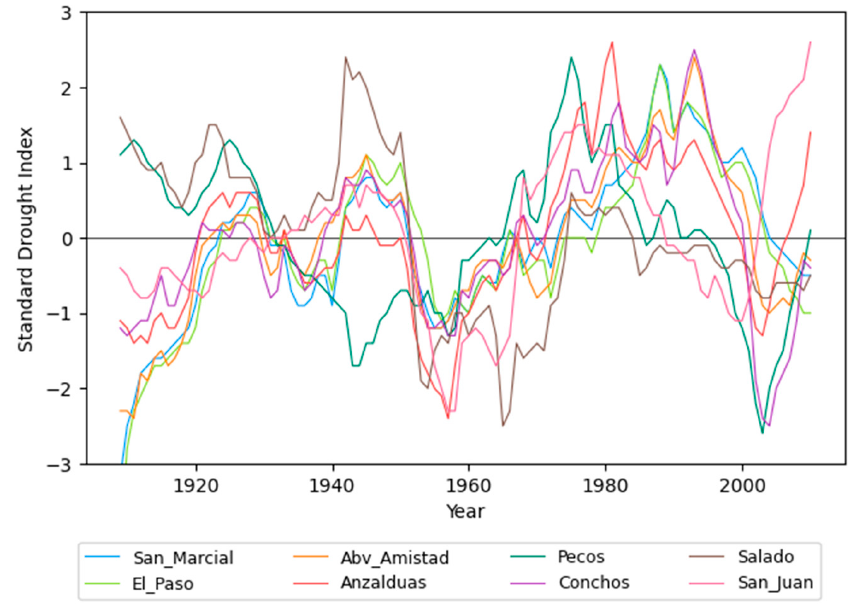
Figure 3. Streamflow drought index of the naturalized control points of the Rio Grande-Bravo Basin.